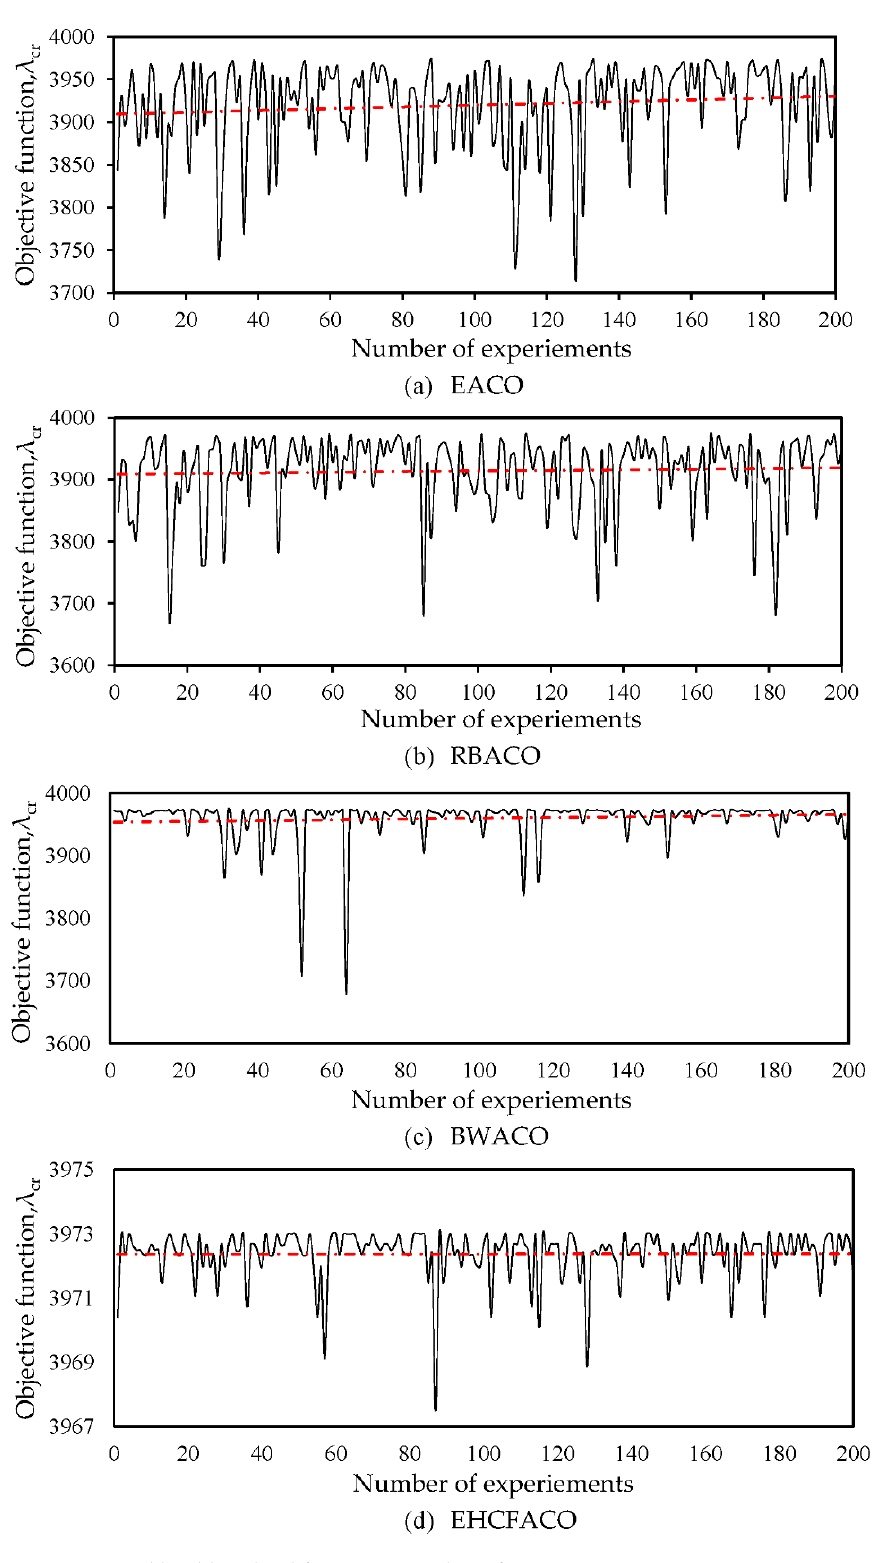
Figure 5. Critical buckling load factor vs. number of experiments.